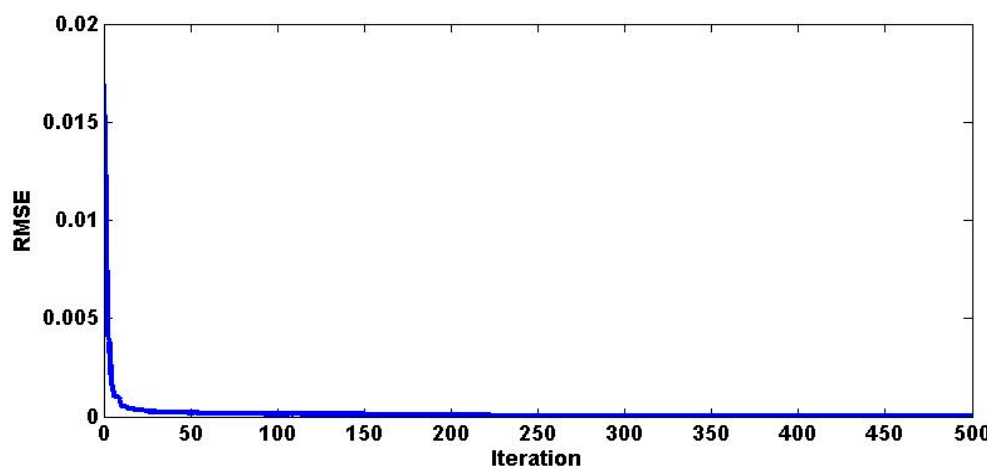
Figure 5. Convergence rate of the MDDM using EHO.